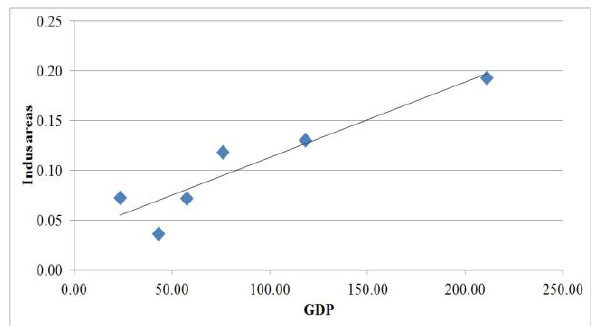
Figure 20. Relationship between GDP and Industrial areas without Edmonton and Victoria City for 2010 ( R 2 = 0.84)